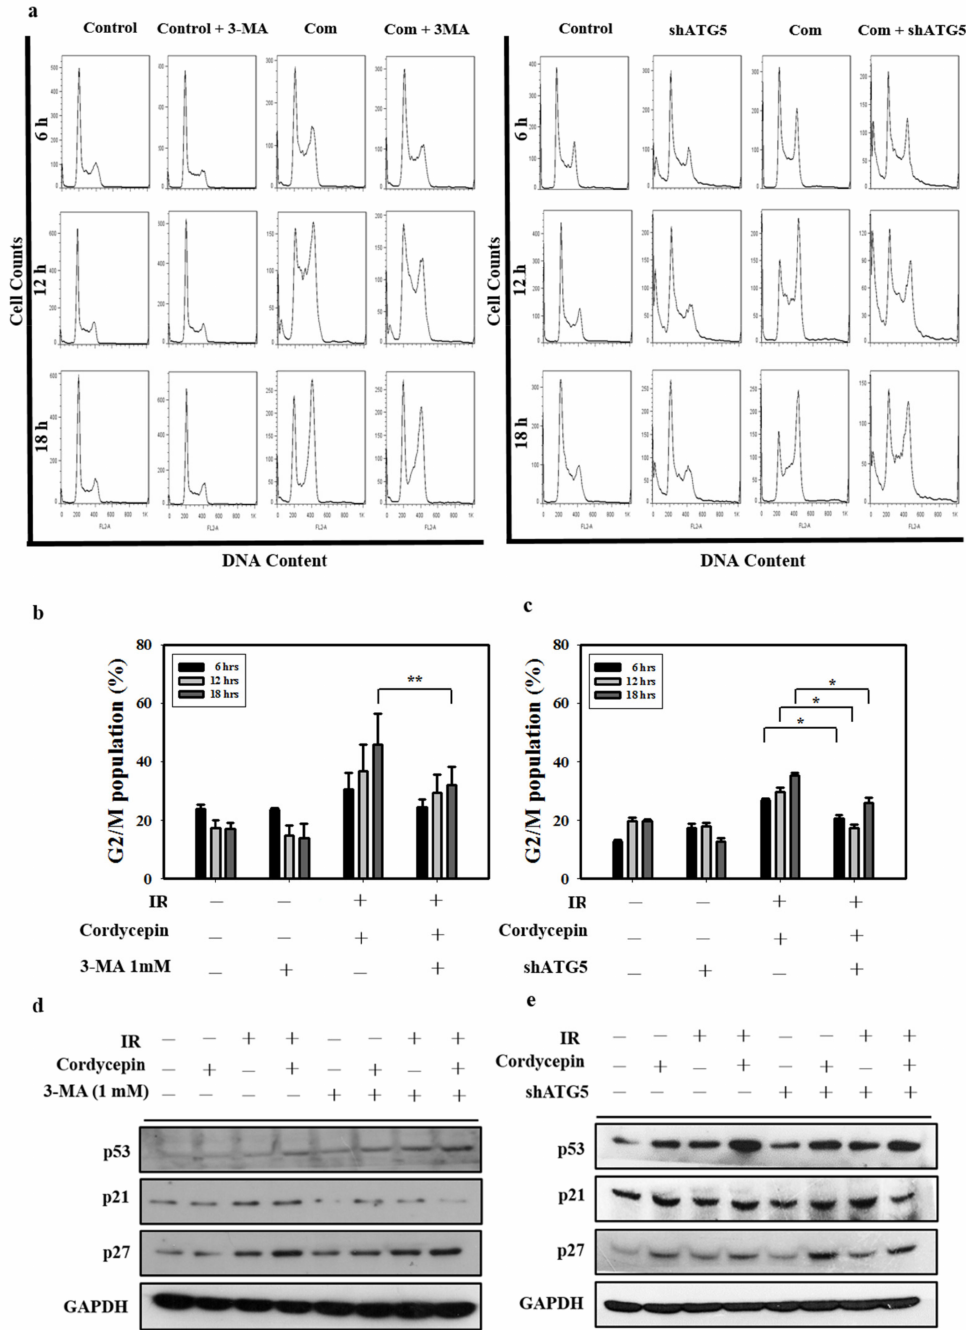
Figure 6. Cordycepin and IR induce G2 / M cell cycle arrest through autophagy induction in oral cancer cells. ( a ) Cell cycle distribution after treatment with 3-MA (1 mM) and shATG5 plus cordycepin (50 µ M) and / or IR (4 Gy) for 6, 12, and 18 h in SAS cells. ( b ) Quantification of G2 / M phase. Cells were pretreated with 3-MA (1 mM) followed by cordycepin (50 µ M) and / or IR (4 Gy) for 6, 12, and 18 h. ** p < 0.01. ( c ) Quantification of G2 / M phases. SAS cells were transfected with ATG5 shRNA and treated with cordycepin (50 µ M) and / or IR (4 Gy) for 6, 12, and 18 h. * p < 0.05. ( d ) Western blot analysis of p53, p21, and p27 expression in the absence and presence of 3-MA. Cells were pretreated with 3-MA (1 mM) for 1 h before receiving the combined treatment (4 Gy IR and 50 µ M cordycepin) for 24 h. ( e ) Western blot analysis of p53, p21, p27, and ATG5 protein expression in SAS cells transfected with ATG5 shRNA. shATG5 cells were treated with 4 Gy IR and / or 50 µ M cordycepin for 24